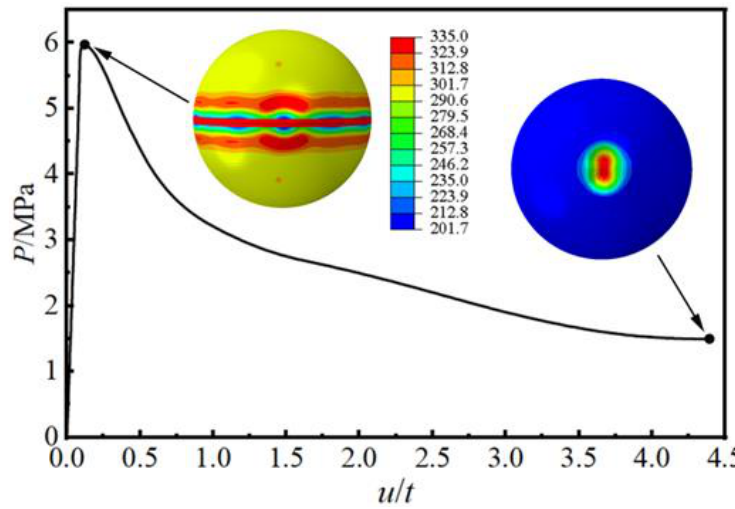
Figure 12. Equilibrium path curve of the spherical shell.